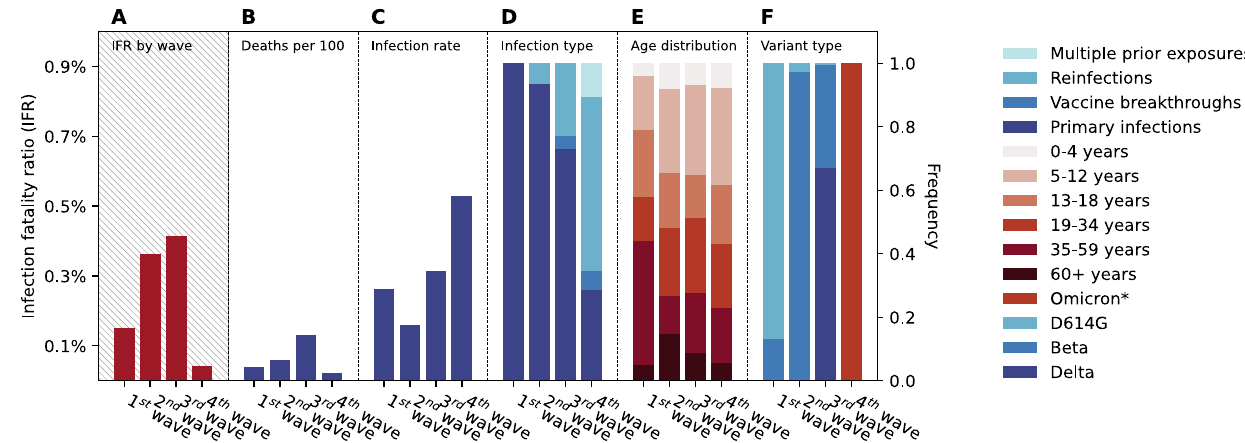
Fig.4|TheinfectionfatalityratiosandthefactorsassociatedwithSARS-CoV-2 disease severityfor different epidemic waves in the urban site ’ s district. A The estimatedinfectionfatalityratioforeachepidemicwave. B Themortalityburdenof eachepidemicwavemeasuredbythecumulativerateofin-hospitaldeathsper100 individuals. C The infection attack rate of each epidemic wave in the North West basedonthePHIRST-Curbancohort,assumingthattheurbancohortpopulationis representative of the population of the North West Province. D The wave-speci fi c distributionofinfectiontypesbasedonpriorexposurehistories,includingprimary infection, vaccine breakthroughs (1 or 2 doses of vaccines), reinfections (infection